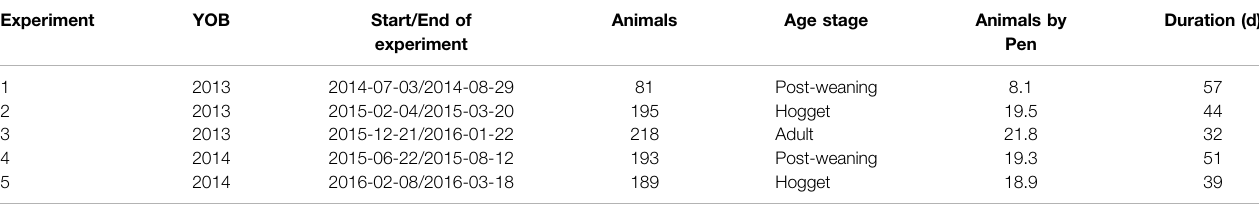
TABLE2| Feedexperimentsdetailsonpost-weaning,hogget,andadultAustralianMaternalCompositesheep.YOB:Yearofbirthofanimals;Animals:Numberofanimalsin the experiment; Animals by pen: Mean number of animals by pen; Duration: test duration (days).